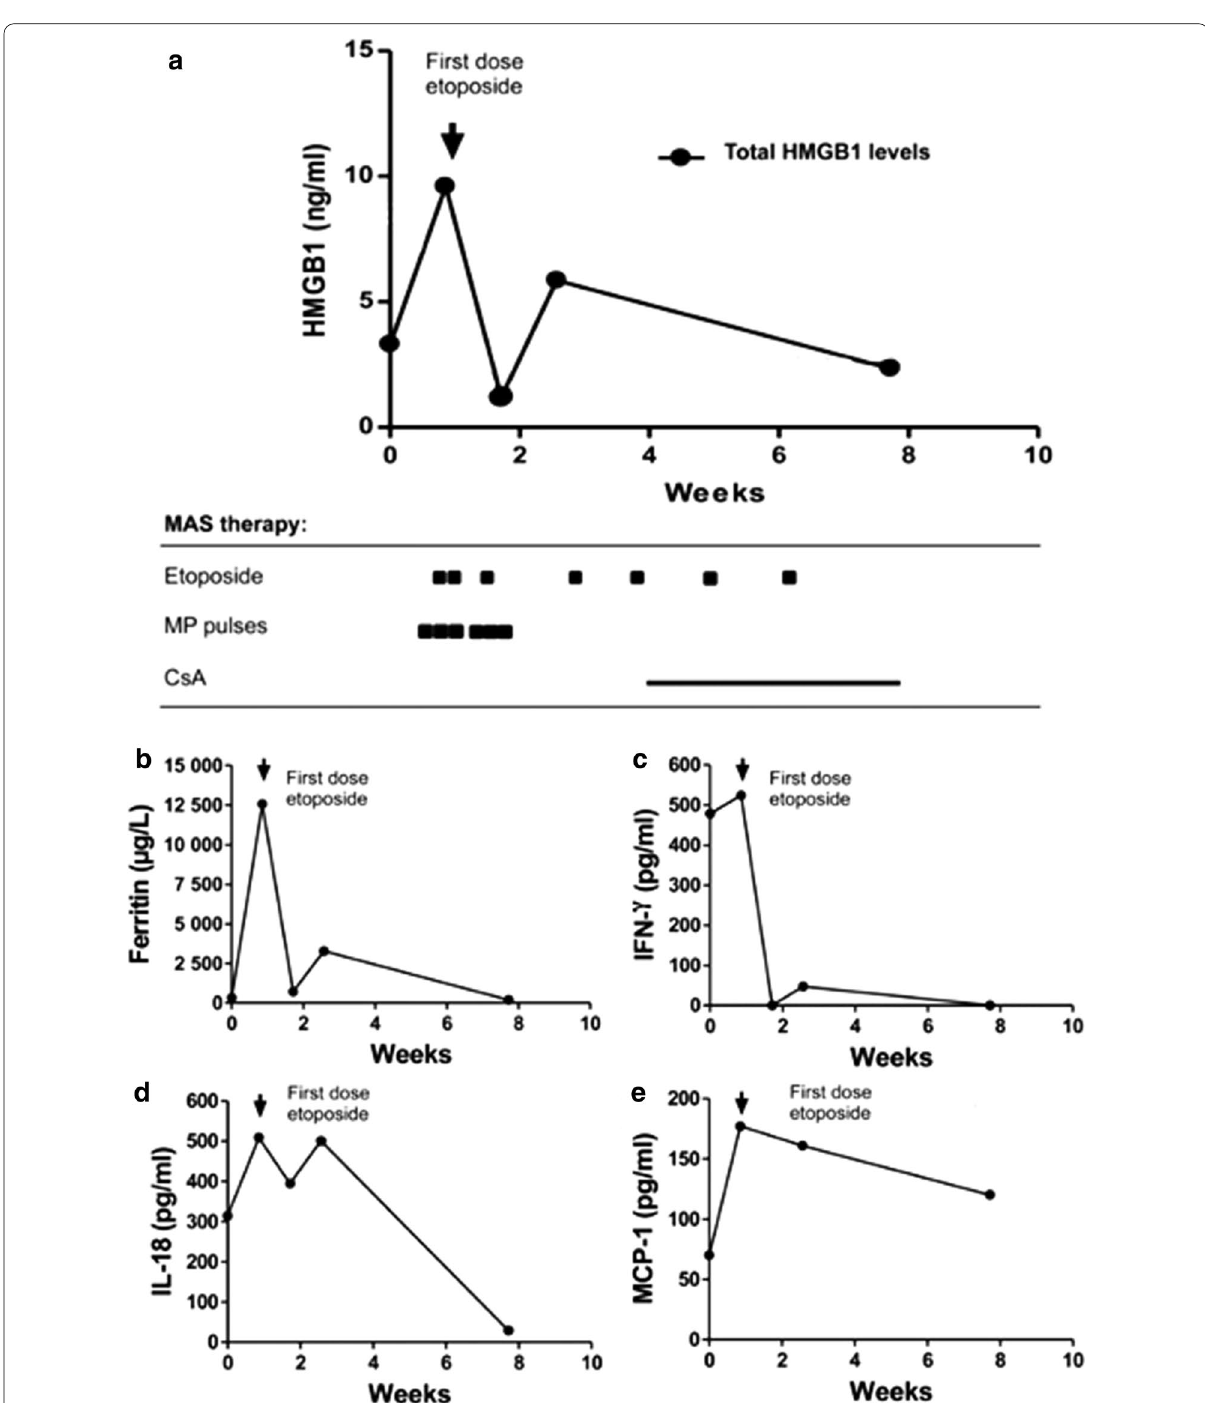
Fig. 3 Serum analyses in patient #2 before and after treatment with etoposide. Two blood samples taken before and after etoposide therapy were analyzed when normalized levels of HMGB1 ( a ), ferritin ( b ) and IFN‑γ ( c ) where documented after intervention with etoposide and subsequent clinical improvement. IL‑18 declined but was still elevated ( d ) while MCP‑1 increased ( e ). CsA cyclosporine